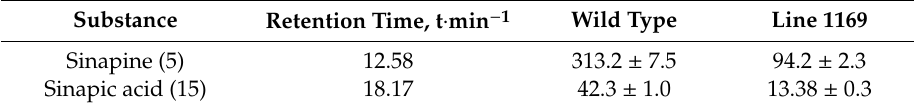
Table 4. Content of sinapine and sinapic acid (mg 100 g − 1 ) in seeds of WT and glossy